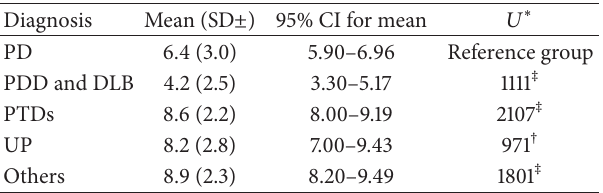
Table 2: Mean “Sniffin Sticks”